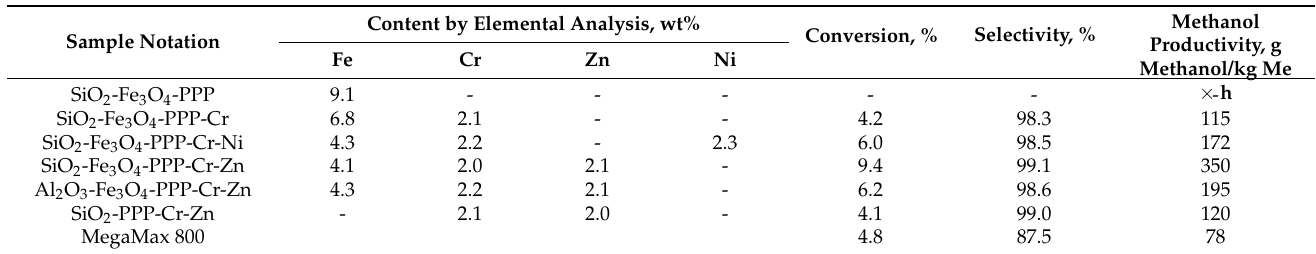
Table 2. Catalytic properties of the nanocomposites in methanol synthesis from CO 2 + H 2 .